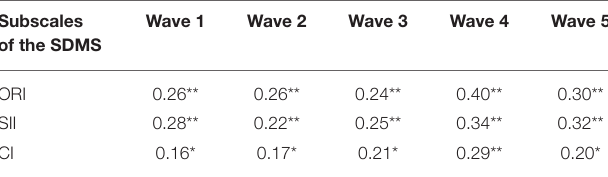
TABLE 3 | MCS as a predictor for the SDMS subscales: ORI (information about own results), SII (self-improvement information), and CI (comparison information concerning own and others’ results) at all five waves of the